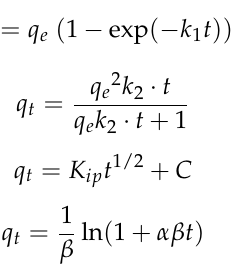
Figure 3. Variations with time of the adsorption capacity and removal efficiency of ( a ) Pb 2+ and ( b ) Ni 2+ by PANmod.